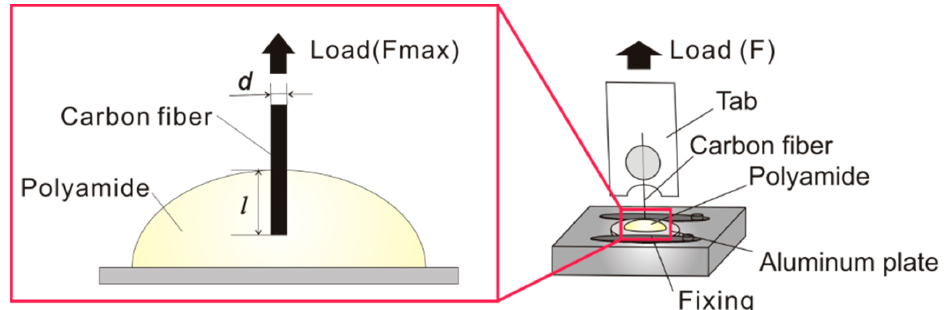
Figure 4 . Schematic drawing of the single fiber pull-out test.